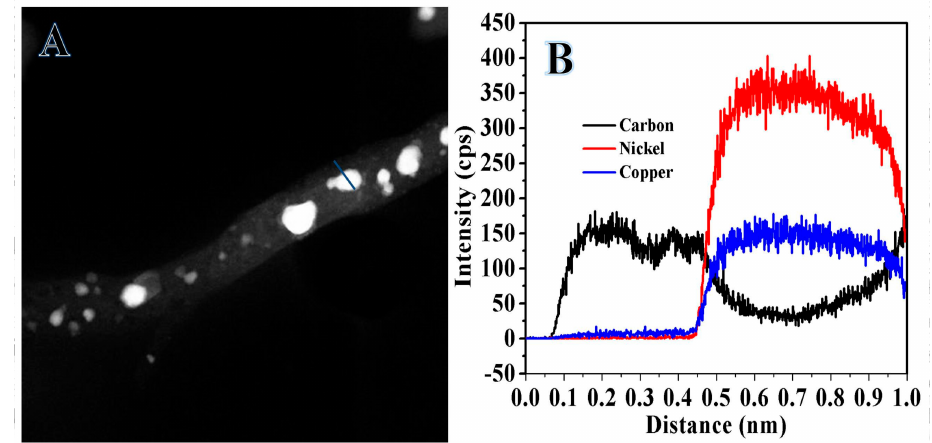
Figure 6. STEM image for a single nanofiber along with the line EDX analysis ( A ) and TEM EDX results for the line in A ( B